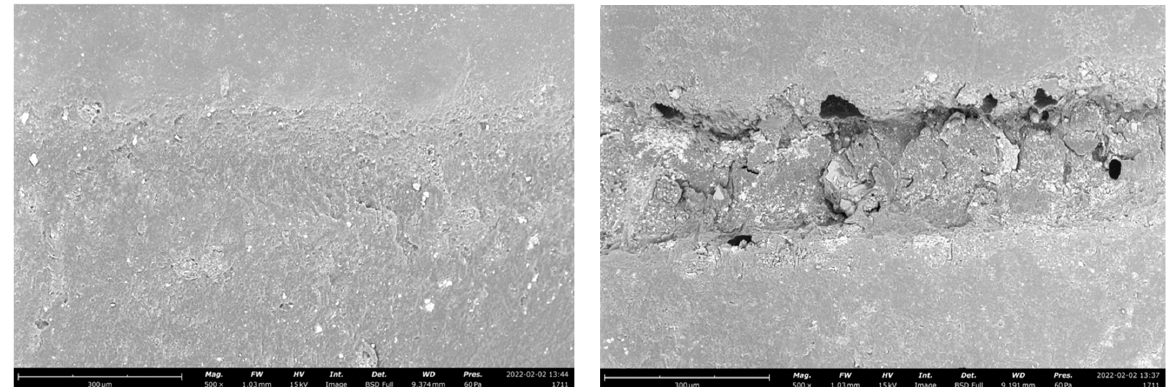
Figure 1. Representative SEM images of the adhesive interface of an adhesive crown before ( left ) and after ( right ) the chewing simulation test, restored with lithium disilicate.